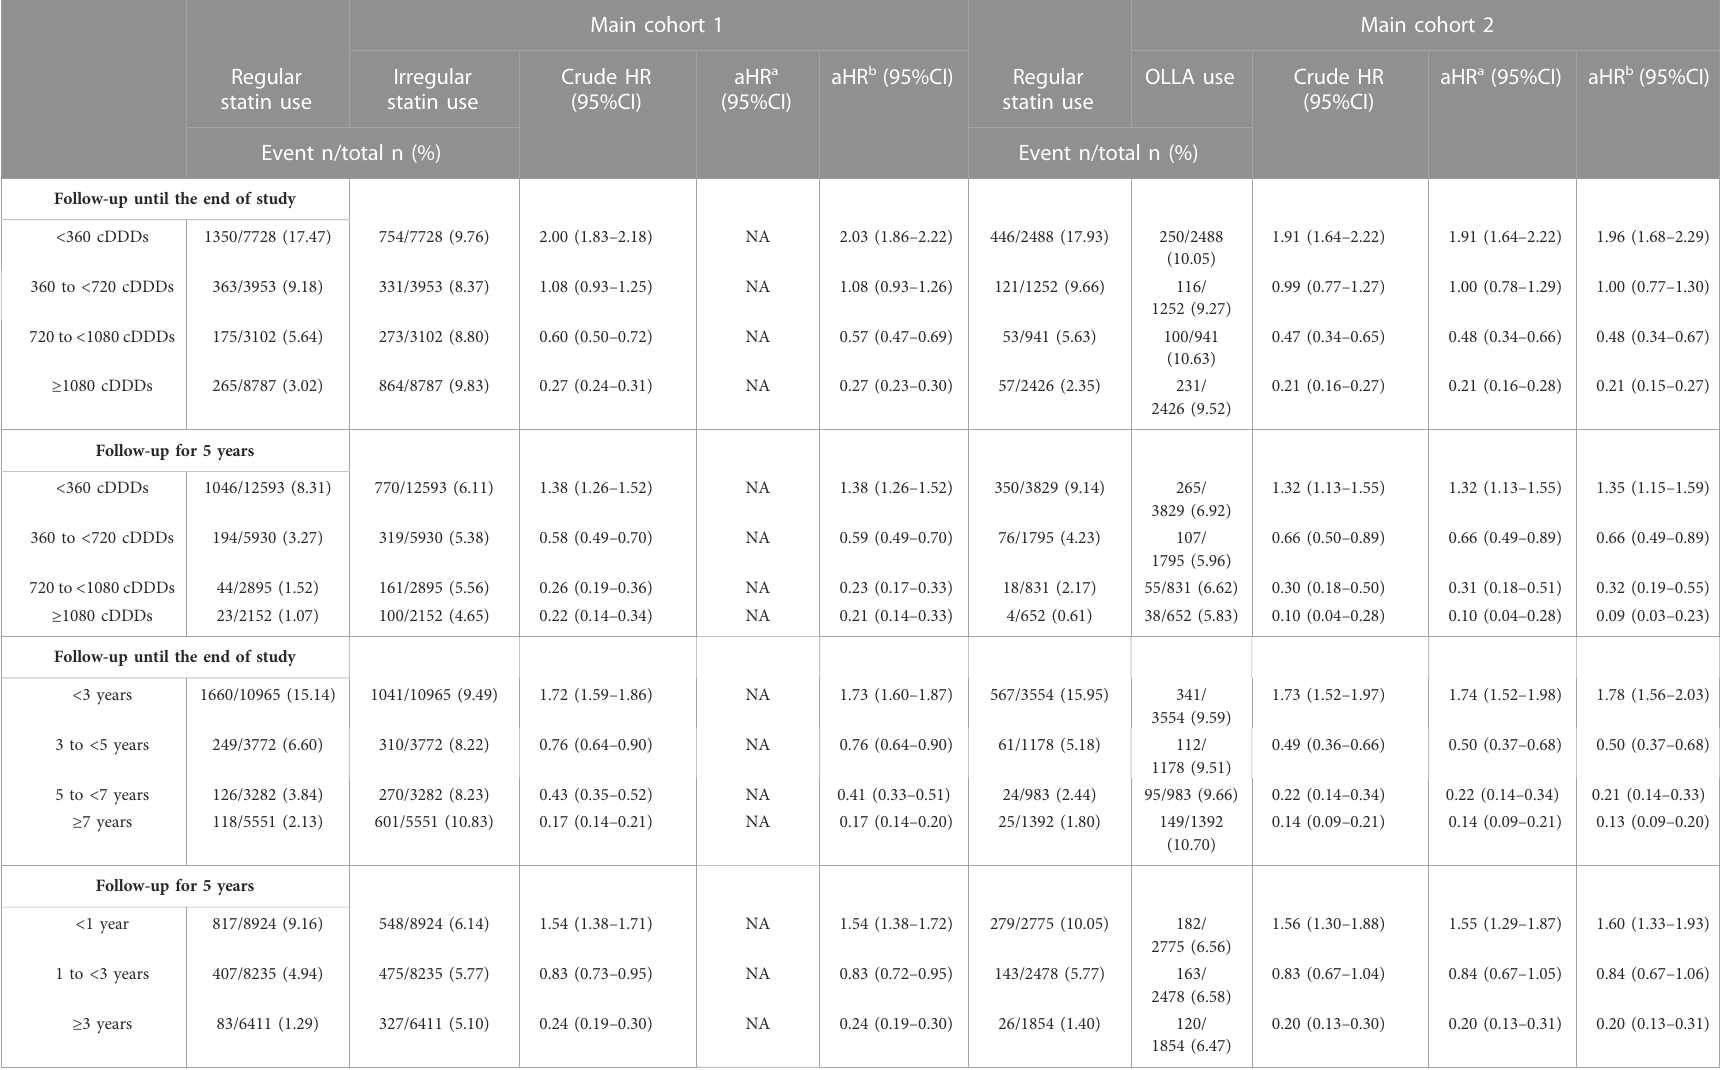
TABLE 3 Dose- and duration-related analyses and sensitivity analyses of statin use and the gout risk in 2 main